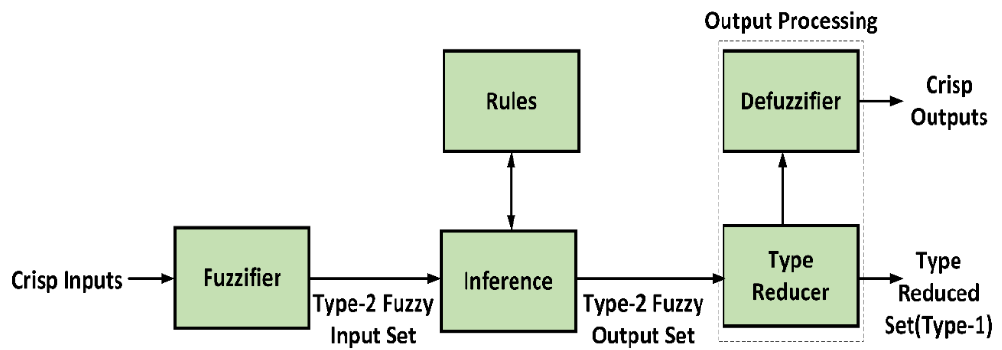
Figure 4. The internal structure of the Interval Type-2 Takagi Sugeno Kang fuzzy logic controller (IT2-TSK-FLC).